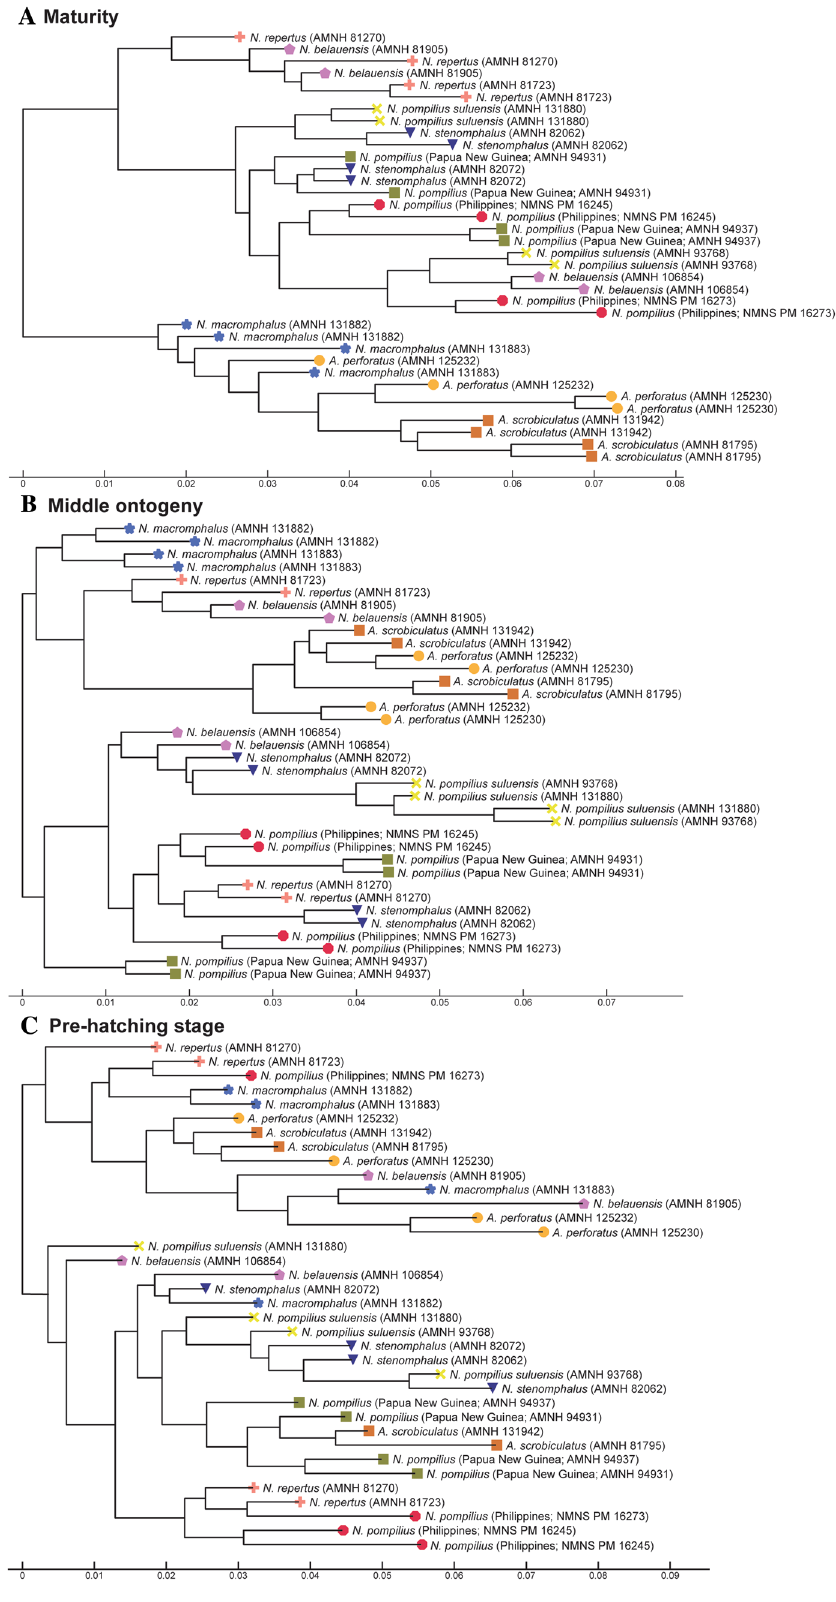
Figure 4. Trees for suture line. ( A ) Maturity (last two chambers). ( B ) Middle ontogeny (a diameter of about 50 mm). ( C ) Pre-hatching stage (a diameter of about 20